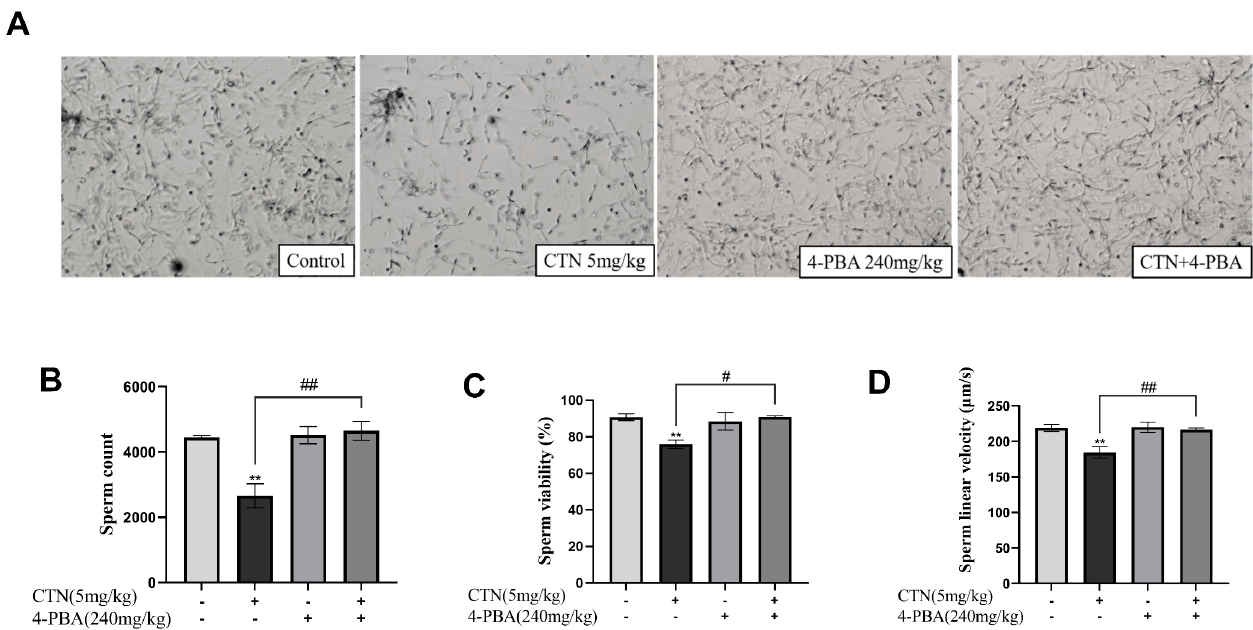
Figure 9. The e ff ects of 4-PBA on testicular damage induced by CTN. ( A ) Morphological observation of testes; ( B ) Testicular index; ( C ) Serum testosterone concentration; ( D ) Assessment of histopatho- logical damage. (Blue: enlarged intercellular matrix; orange: increased luminal diameter; red: con- gested and dilated blood vessels; green: detached luminal cells). The above data are expressed as SEM ± mean, compared with the CTN group, p < 0.05.